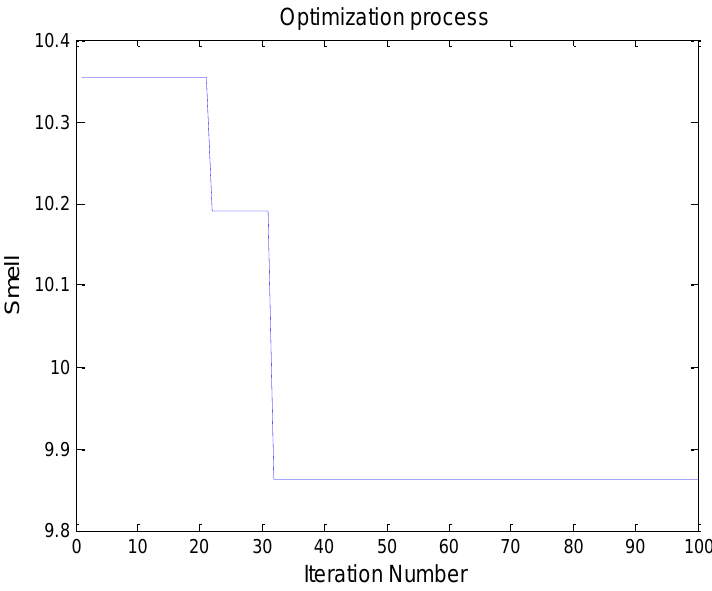
Figure 5. Iterative Smell trend for the CFM searching for optimal parameters.